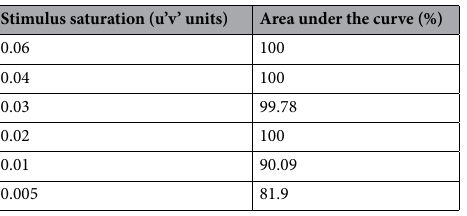
Table 3. Results of the ROC analysis for the different stimulus